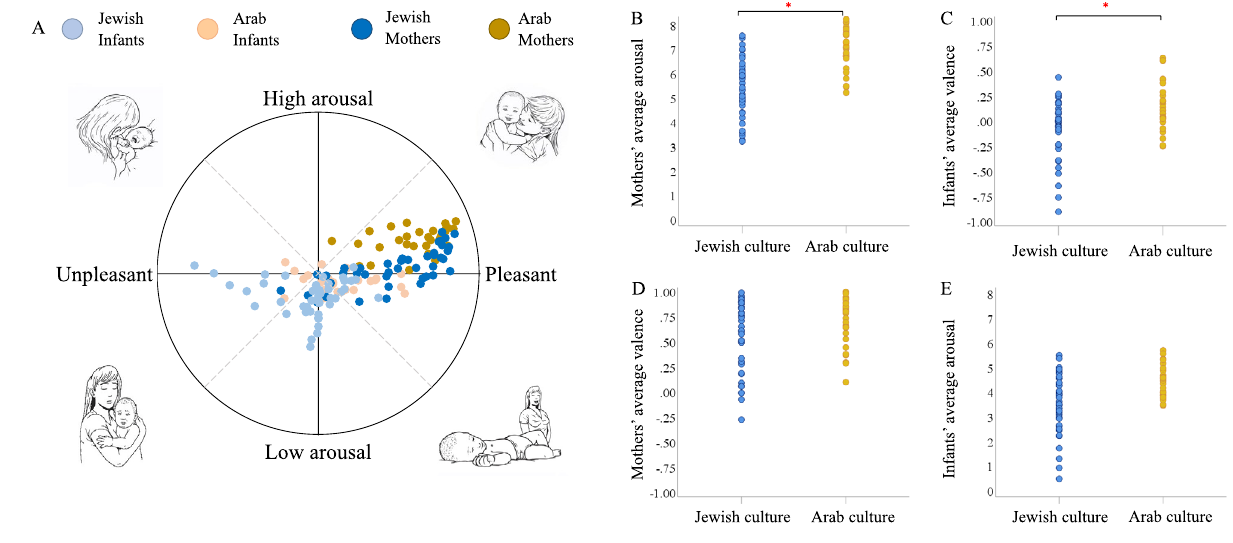
Figure 1. Cultural differences in valence and arousal during free mother–infant interaction. ( A ) The horizontal axis tracks the expression of valence, and the vertical axis tracks the intensity of the affective expression. Jewish participants are represented in shades of blue (dark for the mothers and light for the infants), and Palestinian- Arab participants are represented in shades of yellow (dark for the mothers and light for the infants). ( B ) Cultural differences are found in maternal arousal. ( C ) Cultural differences are found in infant valence. ( D ) Cultural differences were not found in maternal valence. ( E ) Cultural differences were not found in infant